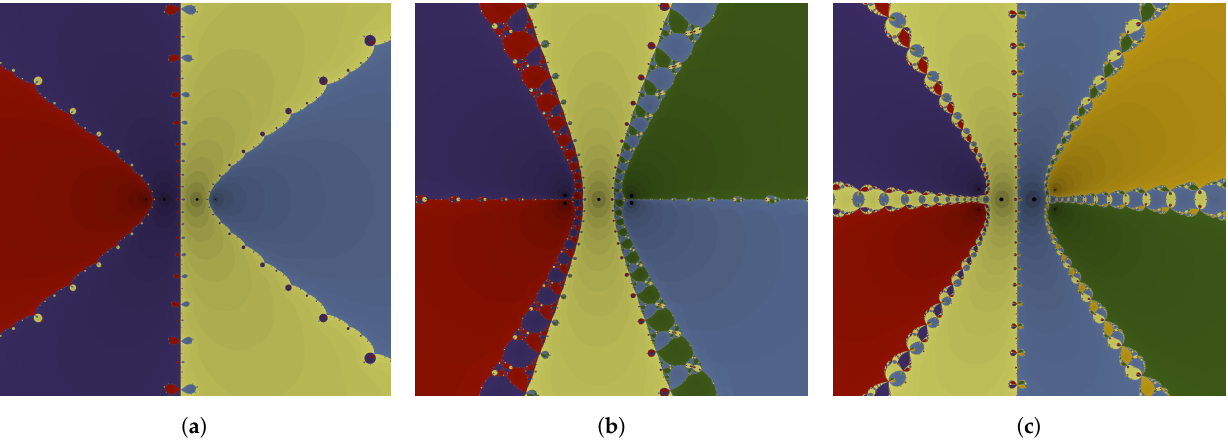
Figure 4. C S n ,0.9, q ( x ,2 ) using Newton’s method for n = 4,5,6 iterating 50-times. ( a ) C S 4,0.9,0.8 ( x ,2 ) ; ( b ) C S 5,0.9,0.8 ( x ,2 ) ; ( c ) C S 6,0.9,0.8 ( x ,2 )